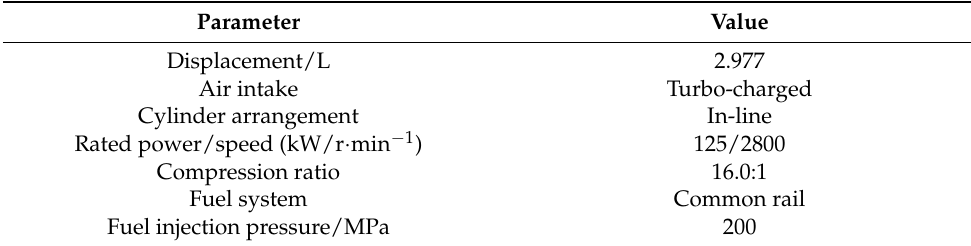
Table 1. Basic engine